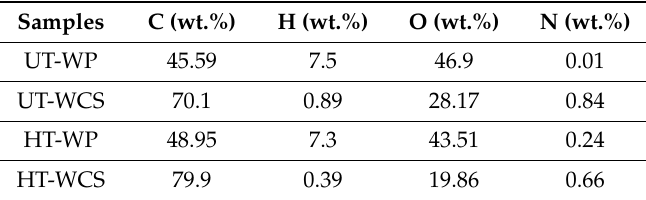
Table 1. Elemental composition of di ff erent